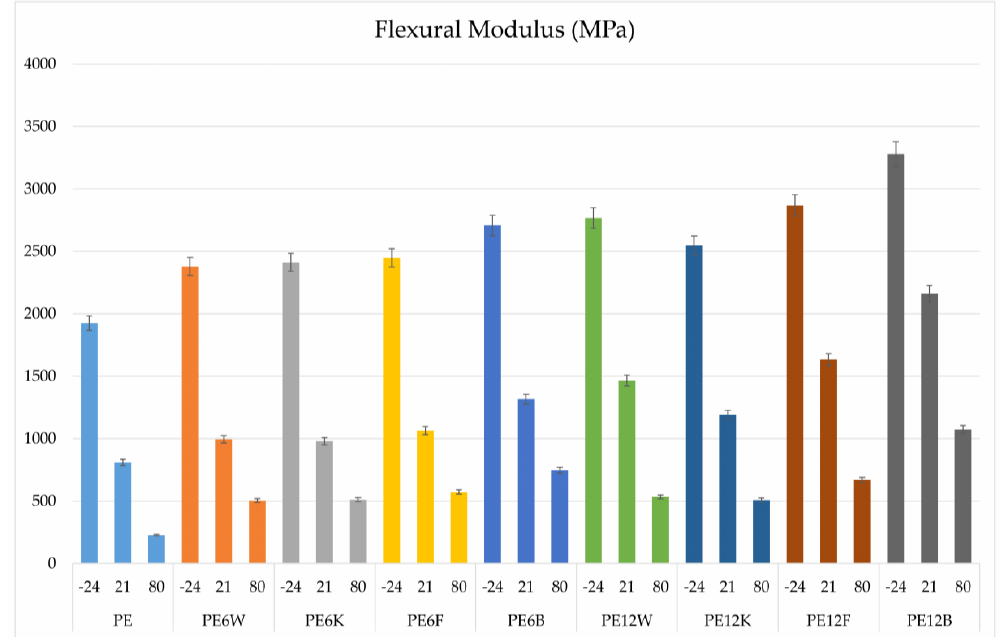
Figure 4. Comparison of flexural strength of tested material.